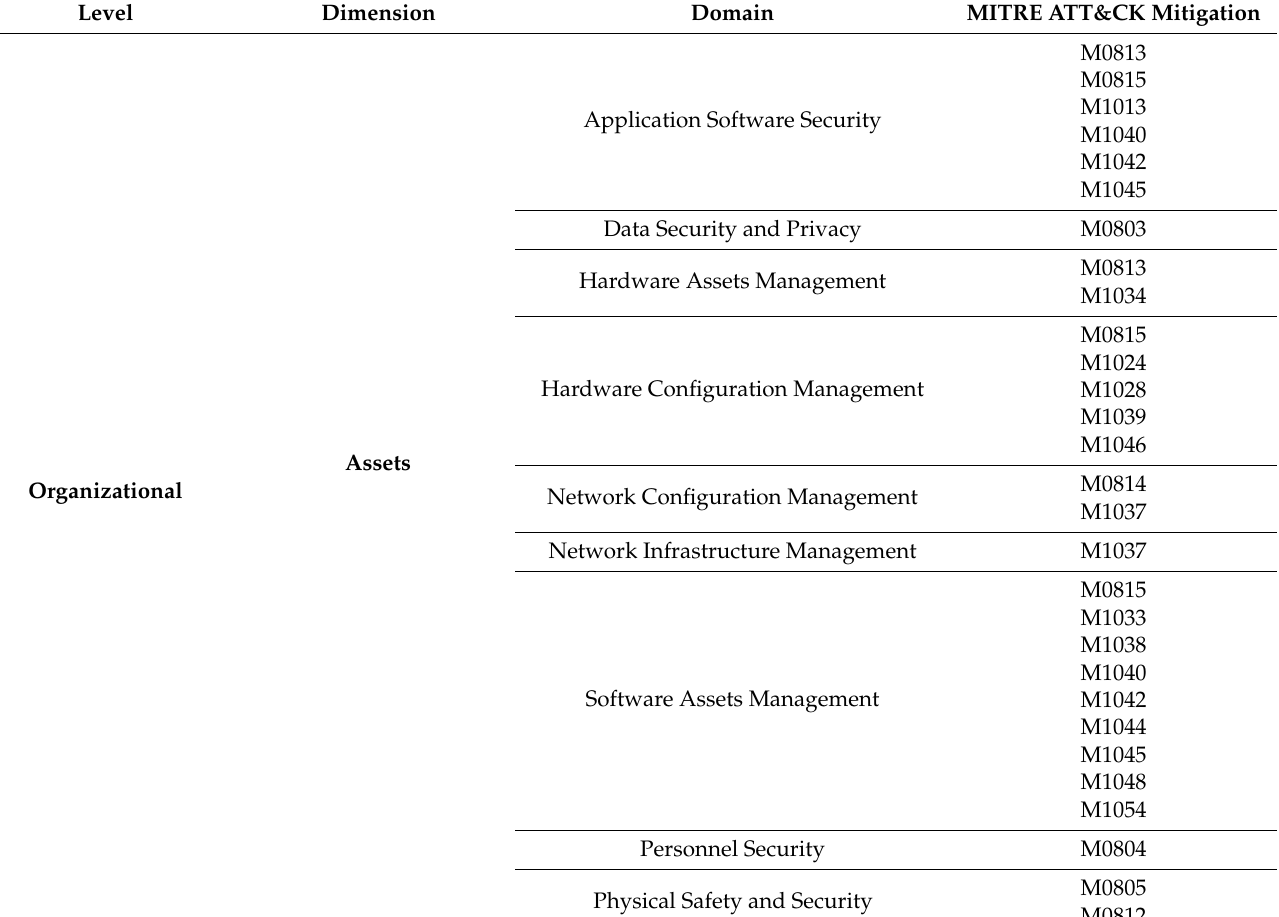
Table 2. Cyber-Security Culture model relation to MITRE ATT&CK for Enterprise and ICS Mitigations. Level Dimension Domain MITRE ATT&CK Mitigation